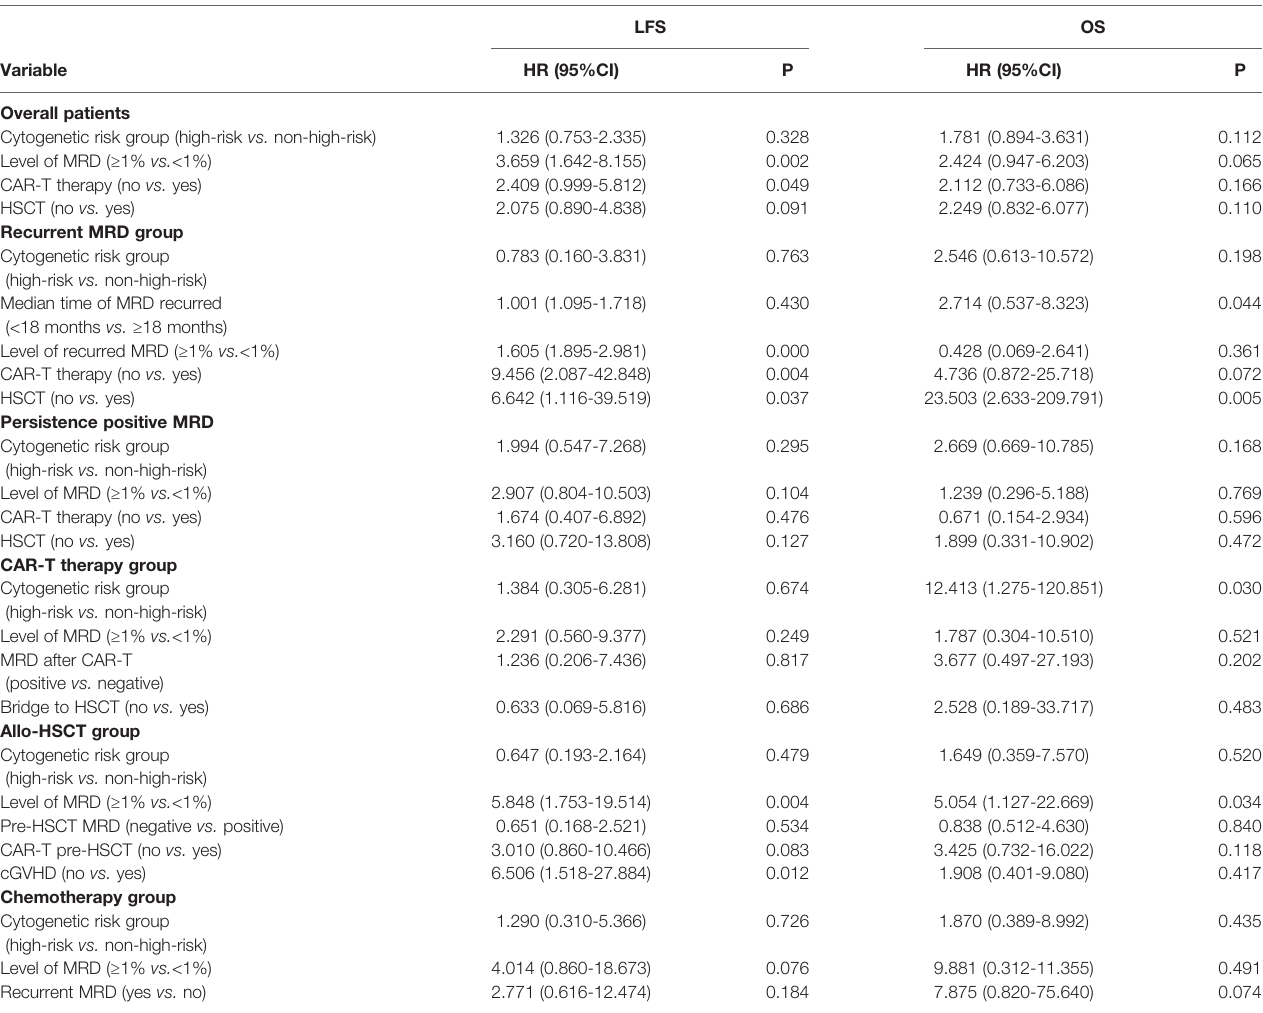
TABLE 5 | Multivariate analysis of factors associated with survival